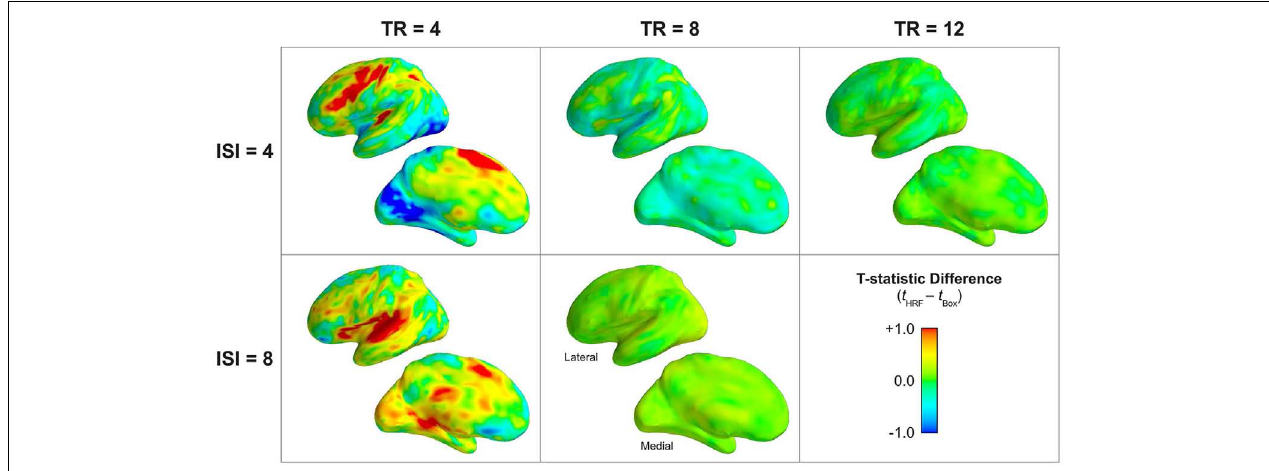
reliability over the boxcar model in nearly all task-activated cortex.This difference was most prominent forTR = 4s, but smaller differences were still evident in temporal, parietal, and frontal regions even forTR = 8 and 12s.The lateral and medial surfaces of the left hemisphere are shown. Supplementary Figure 2 provides a volume-based depiction (axial slices) of these